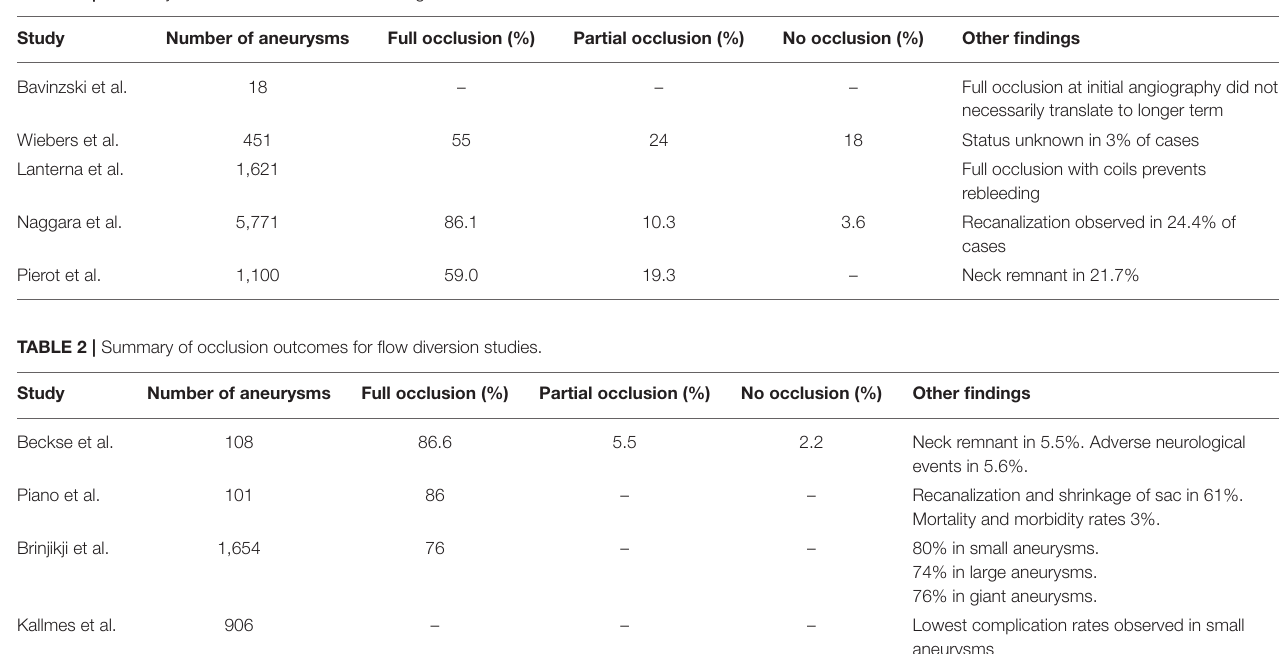
TABLE 1 | Summary of occlusion outcomes for coiling studies.